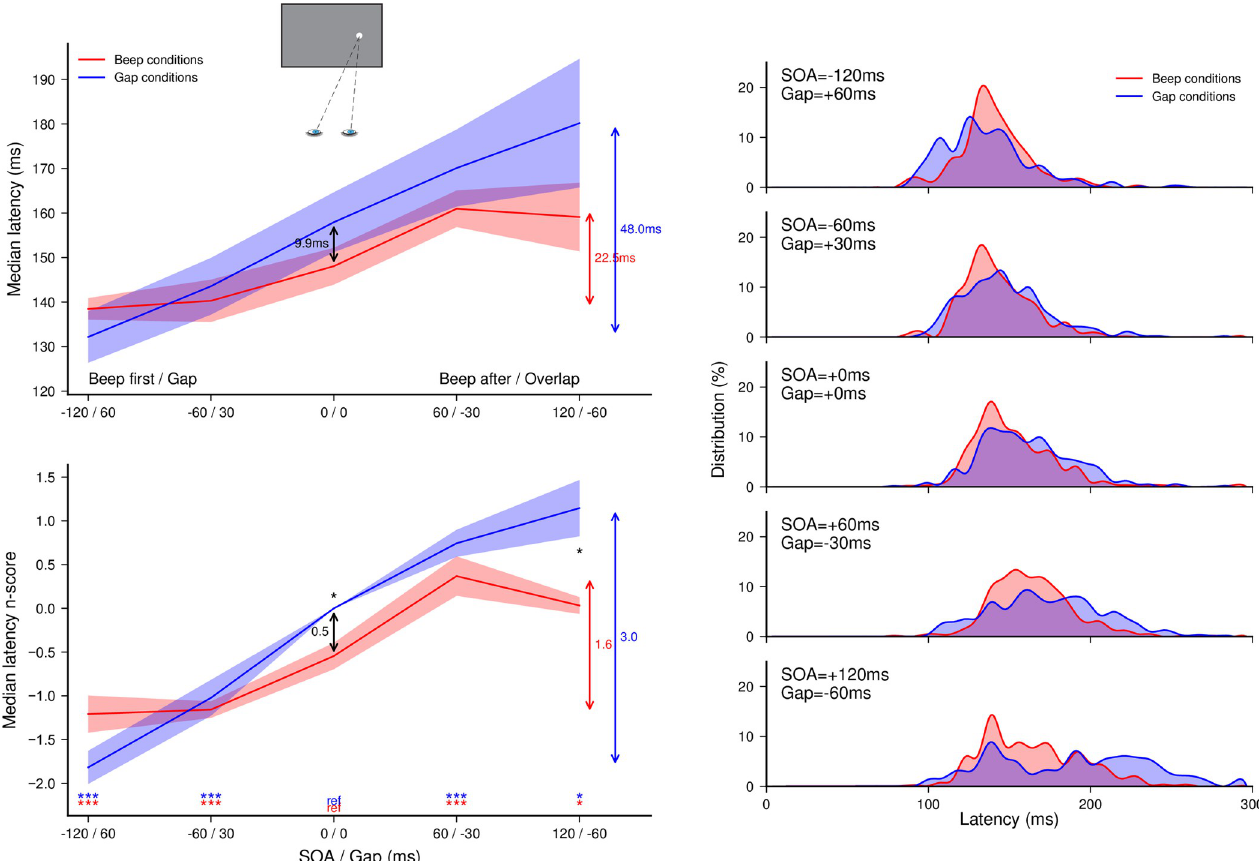
Fig 8. Experiment 3. Comparing the effects of beep MSI modulation and gap/overlap on saccade latency. (Left panel) Median latencies averaged across participants for the Beep conditions (no gap/overlap) and the Gap conditions (no beep) as a function of SOA or gap duration (top), and their corresponding n scores (bottom). Statistics performed for each group of conditions separately on the n scores , included paired t-tests comparing each SOA or gap condition with the 0-ms SOA or Gap duration reference conditions, respectively (colored stars above the X-axis). Three stars indicate highly significant differences after Bonferroni correction (p < 0.0125) while single stars indicate significant differences without correction (p < 0.05). (Right panel) Saccade latency distributions for the Beep conditions and the Gap conditions plotted for each SOA and Gap, respectively, with data pooled from all participants.